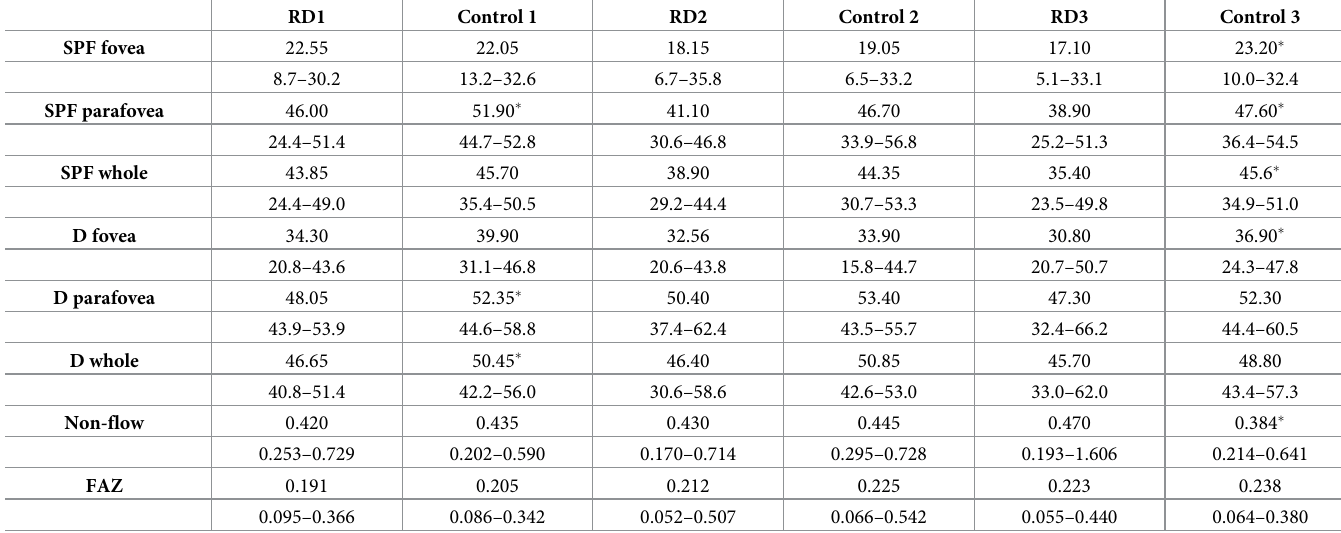
Table 4. Results of OCT-A measurements in